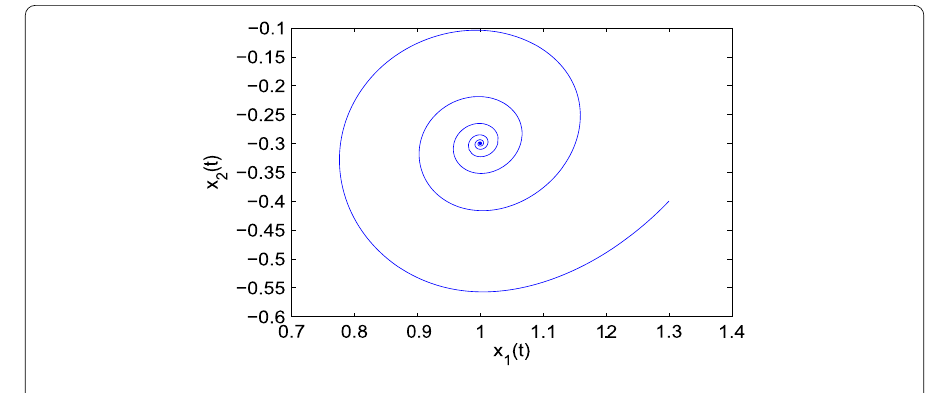
Figure 1 The master system in Example 1